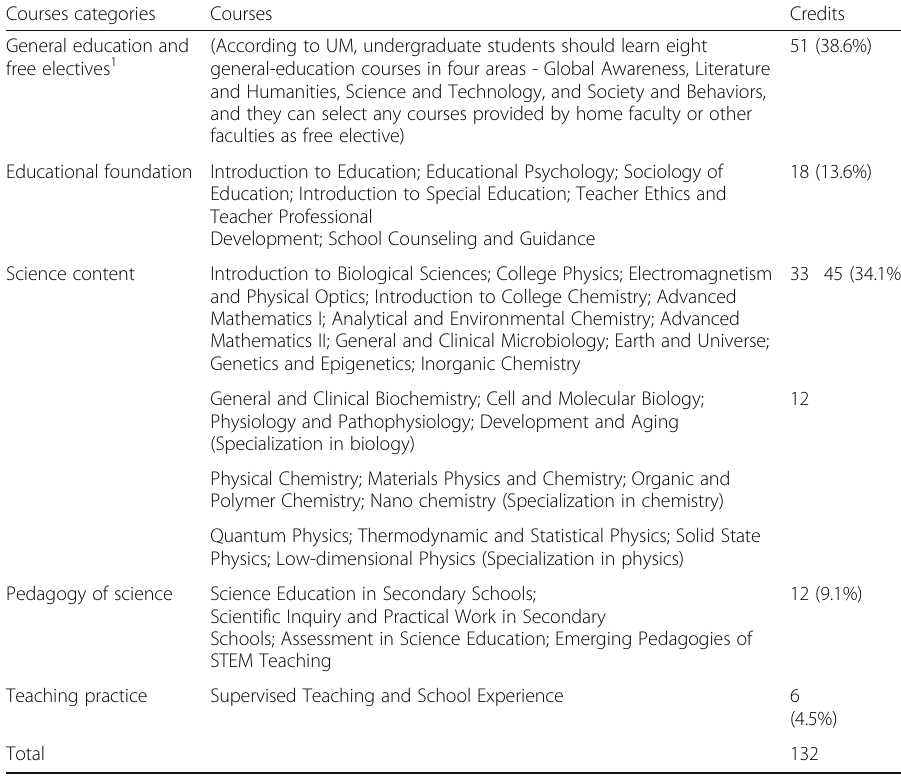
Table 2 The details of the Integrated Science program (Source: FED, 2019) Courses categories Courses